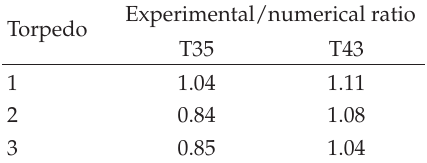
Table 1: Relation between measured and numerical pull-out